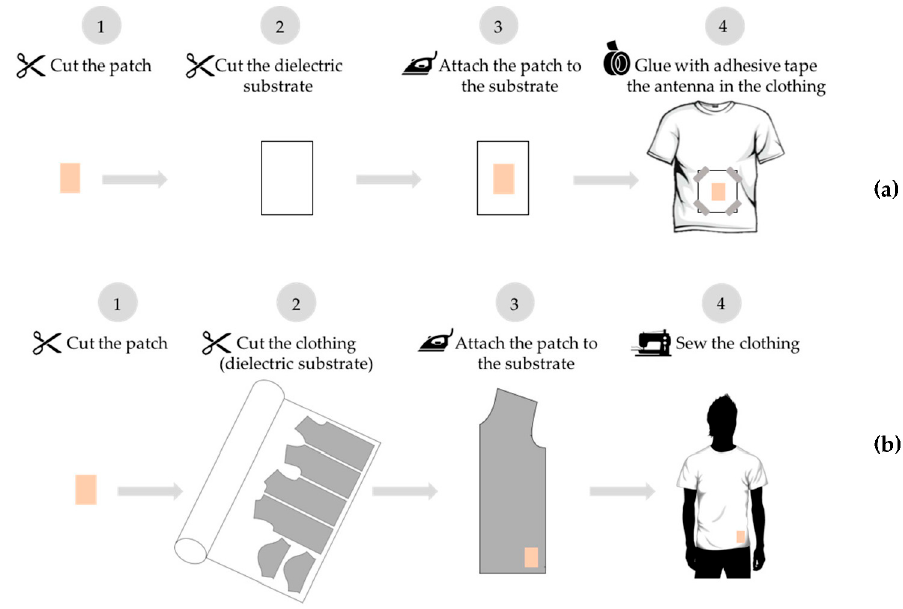
Figure 7. Comparison of techniques of integration of antennas into cloth ( a ) typical integration and ( b ) “emblem” approach.